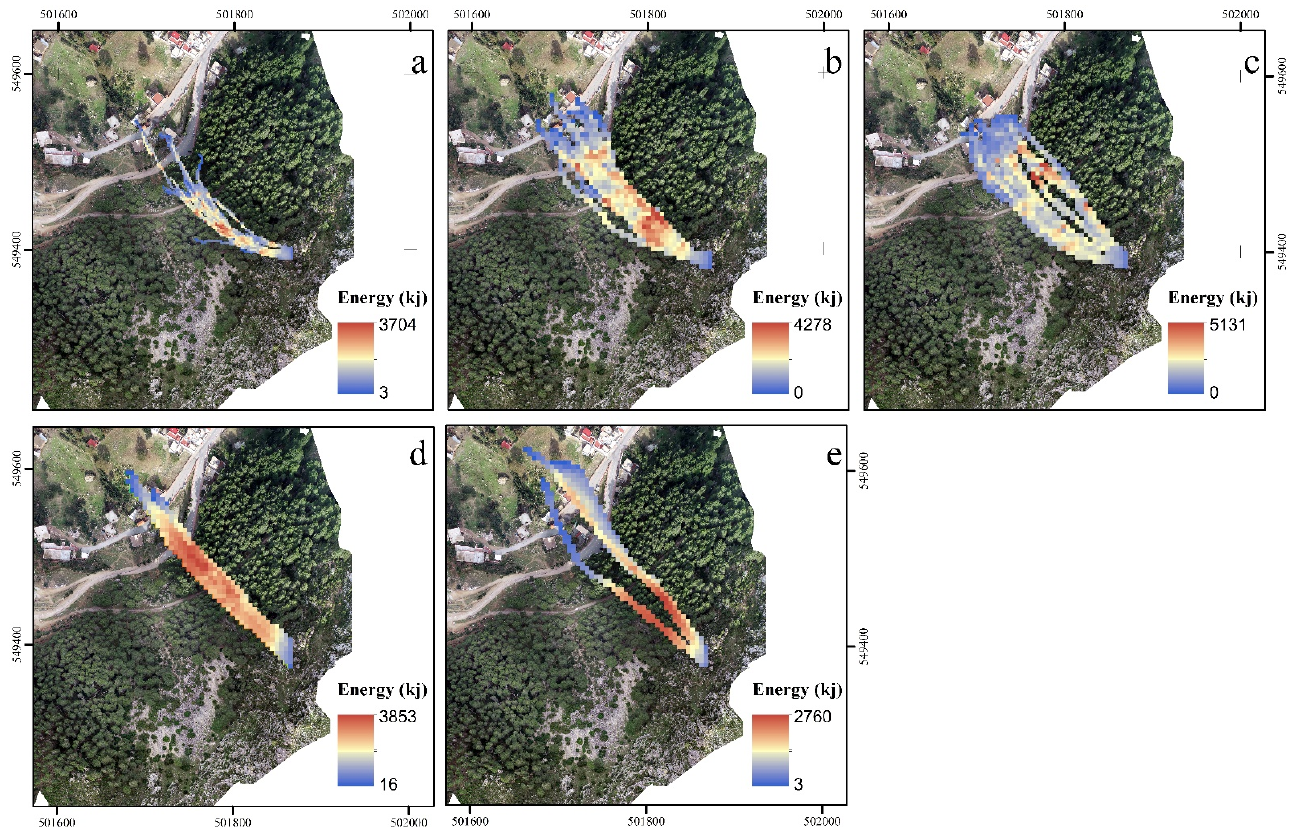
Figure 11. Simulated rockfall energy simulation in the Bouanane cliff obtained using the 1 m DEM ( a ), the 2 m DEM ( b ), the 3 m DEM ( c ), the 5 m DEM ( d ) and the 30 m DEM ( e ). This spatial distribution difference was well attested by the Kruskal–Wallis test re ‐ sults (Table 2) that showed a low P ‐ value output (<0.0001). Given a threshold of 0.05, these findings proved that the observed spatial distribution difference was statistically signifi ‐ cant. The pairwise Dunn test also yielded a similar output for the velocity and energy, with P ‐ values largely inferior to 0.05 (<0.001) (Table 3), with the exception of the 2 m and 3 m DEMs, which appeared to have similar velocity distributions. Table 2. Kruskal–Wallis test results.